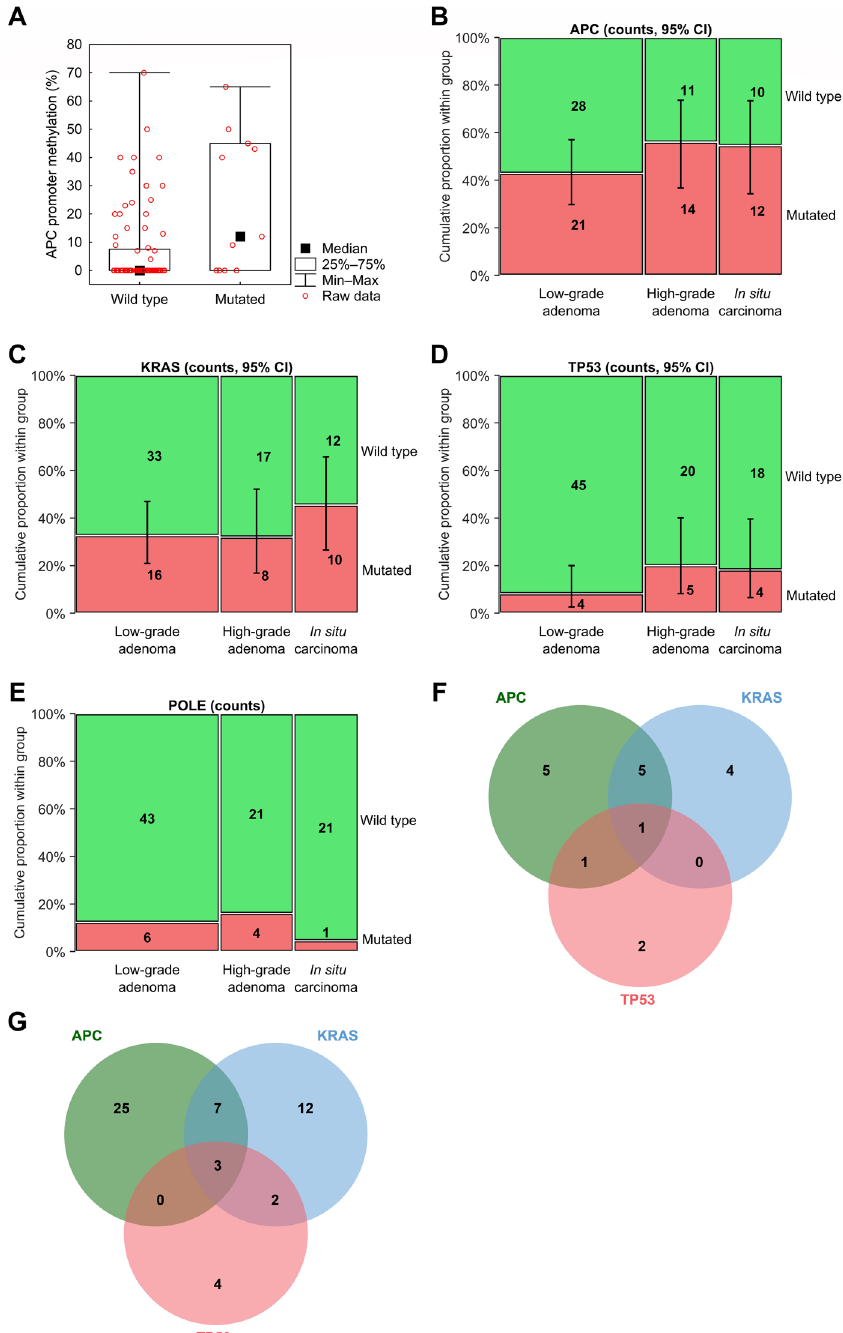
Figure 1. The mutated gene signature of colorectal adenomas and in situ carcinomas. ( A ) The APC promoter methylation distribution with POLE genetic variations, ( B ) The mutation distribution of APC gene between low-, high-grade adenomas and in situ carcinomas, ( C ) The mutation distribution of KRAS gene between low-, high-grade adenomas and in situ carcinomas, ( D ) The mutation distribution of TP53 gene between low-, high- grade adenomas and in situ carcinomas, ( E ) The mutation distribution of POLE gene between low-, high-grade adenomas and in situ carcinomas, ( F ) The Venn diagram of mutations of APC , TP53 , and KRAS genes in in situ carcinomas, ( G ) The Venn diagram of mutations of APC , TP53 , KRAS , and POLE genes in